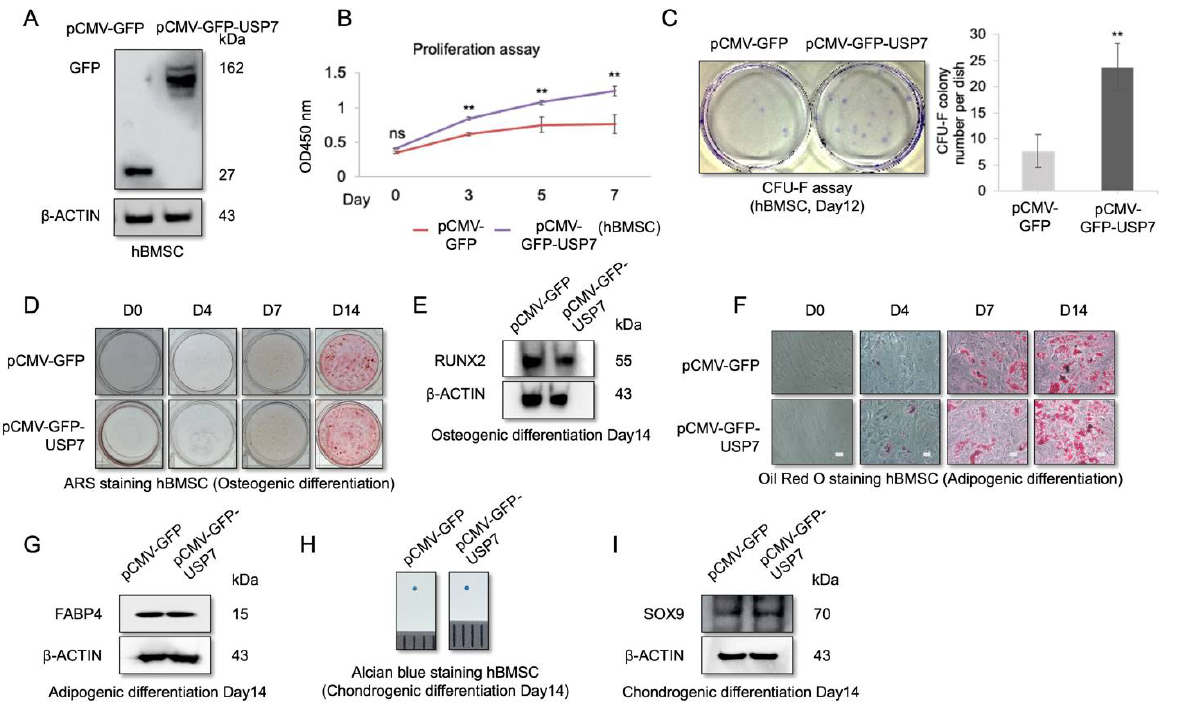
Figure 3. Effect of USP7 overexpression on self-renewal and differentiation of hBMSCs. ( A ) Immunoblot depicting the results of hBMSCs transfected with pCMV-GFP and pCMV-GFP-USP7 vector. ( B ) Cell proliferation analysis results. ( C ) CFU-F assay results. ( D ) ARS staining results. ( E ) Immunoblot analysis of osteogenic markers. ( F ) Oil Red O staining results. Scale bar = 200 μm. ( G ) Immunoblot analysis of adipogenic markers. ( H ) Alcian blue staining results. ( I ) Immunoblot analysis of chondrogenic markers. Data are presented as mean ± SD. ** p < 0.01. n = 3.